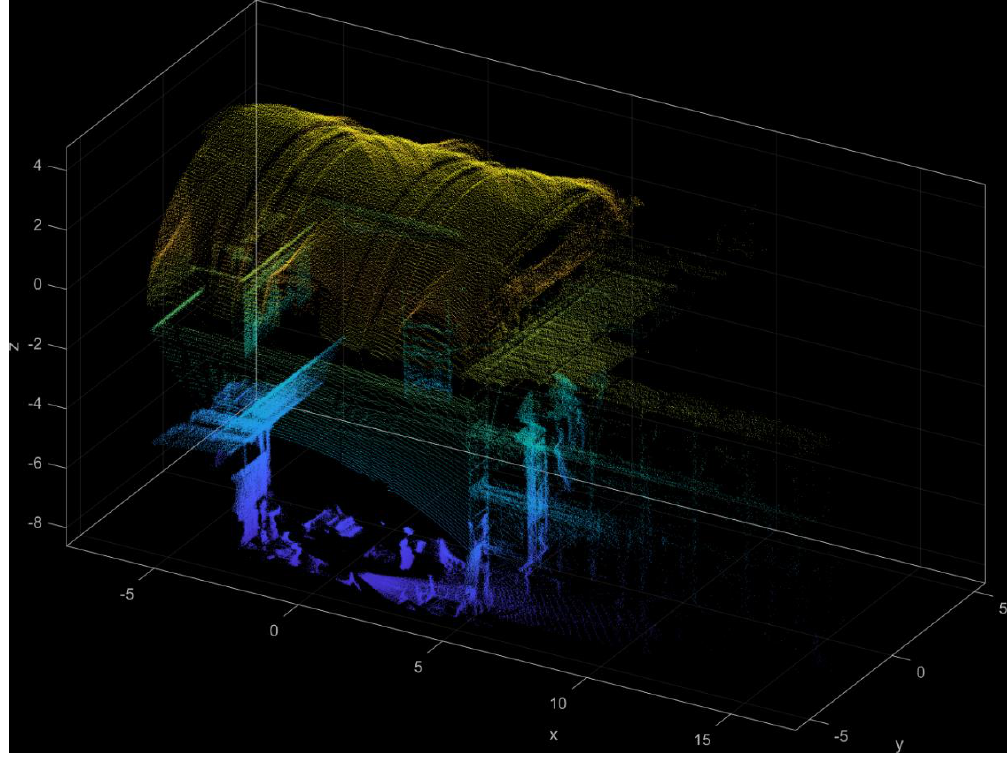
Figure 3. Church of St. Marta: point cloud LiDAR survey (only the first 3 bays were surveyed).